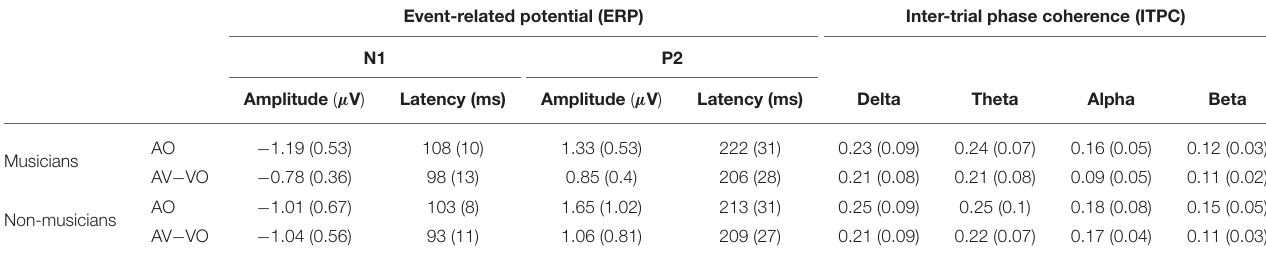
TABLE 3 | Mean and standard deviation (SD) of N1 and P2 amplitude ( µ V ), latency (ms) and ITPC for delta, theta, alpha, and beta activity, for musicians and non-musicians.